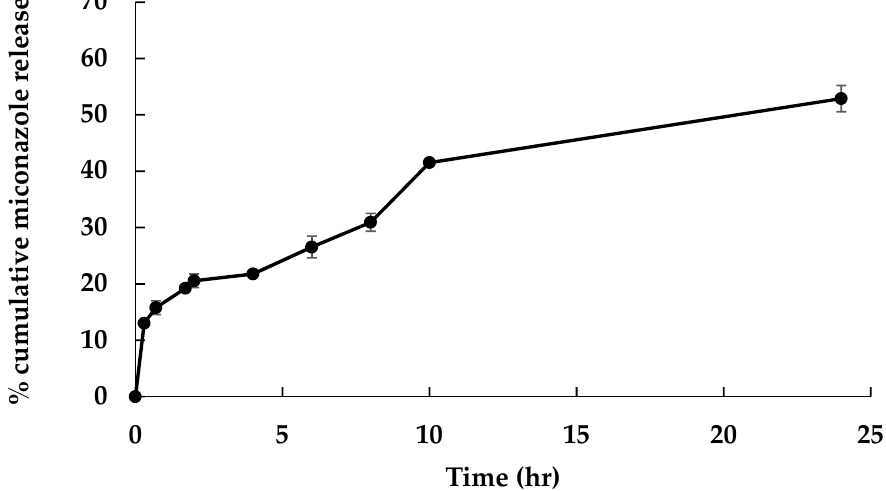
The in vitro release profile of MCZ in CKR12 ‐ PLGA ‐ MCZ micelles in PBS at pH 7.4 was measured by high ‐ performance liquid chromatography (HPLC) (Figure 5).